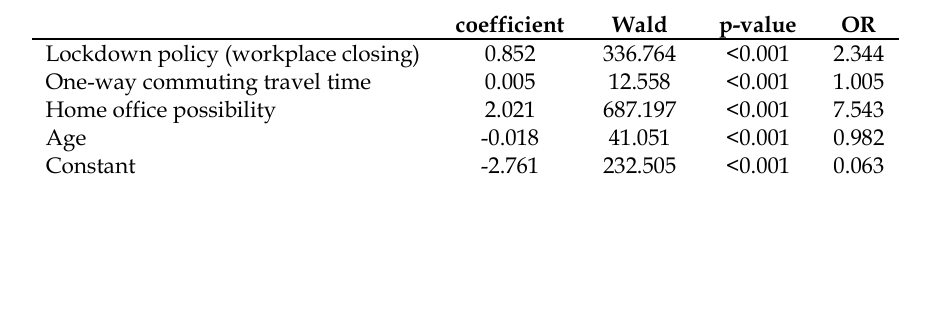
Table 9. Results of binary logistic